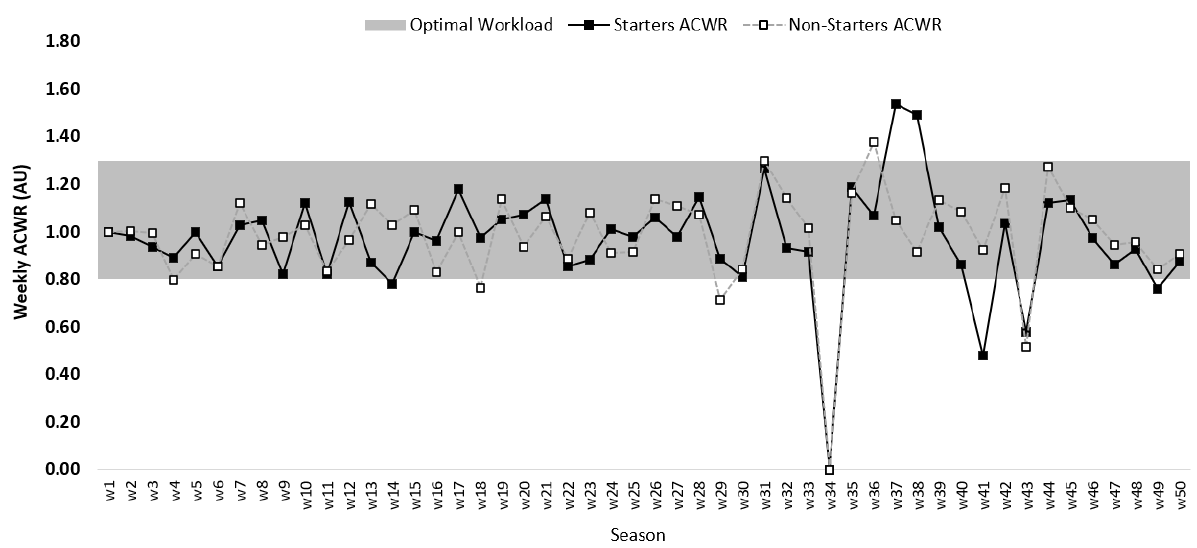
Figure 2. Descriptive statistics of microcycle average for ACWR between starters and